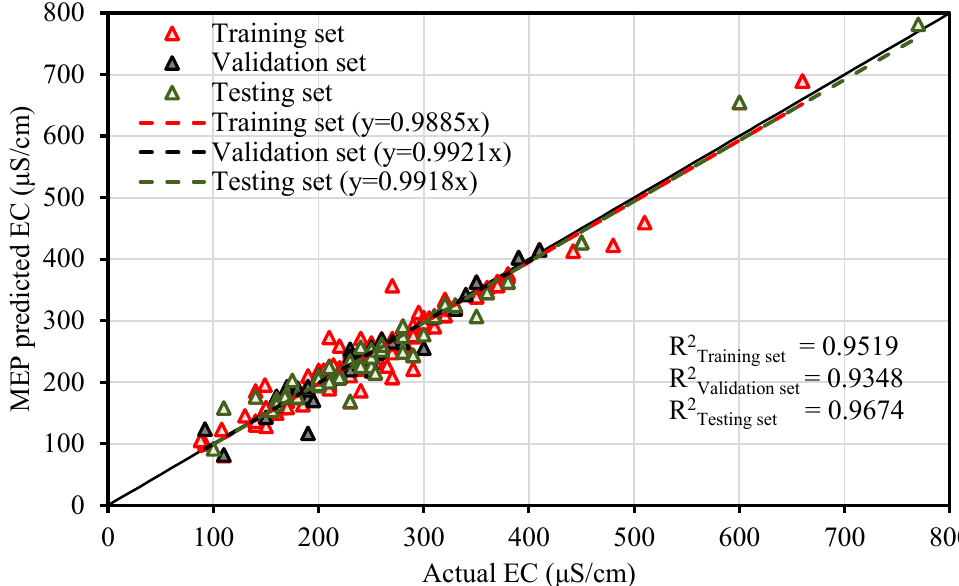
Figure 2. Regression plot of MEP models established for EC.